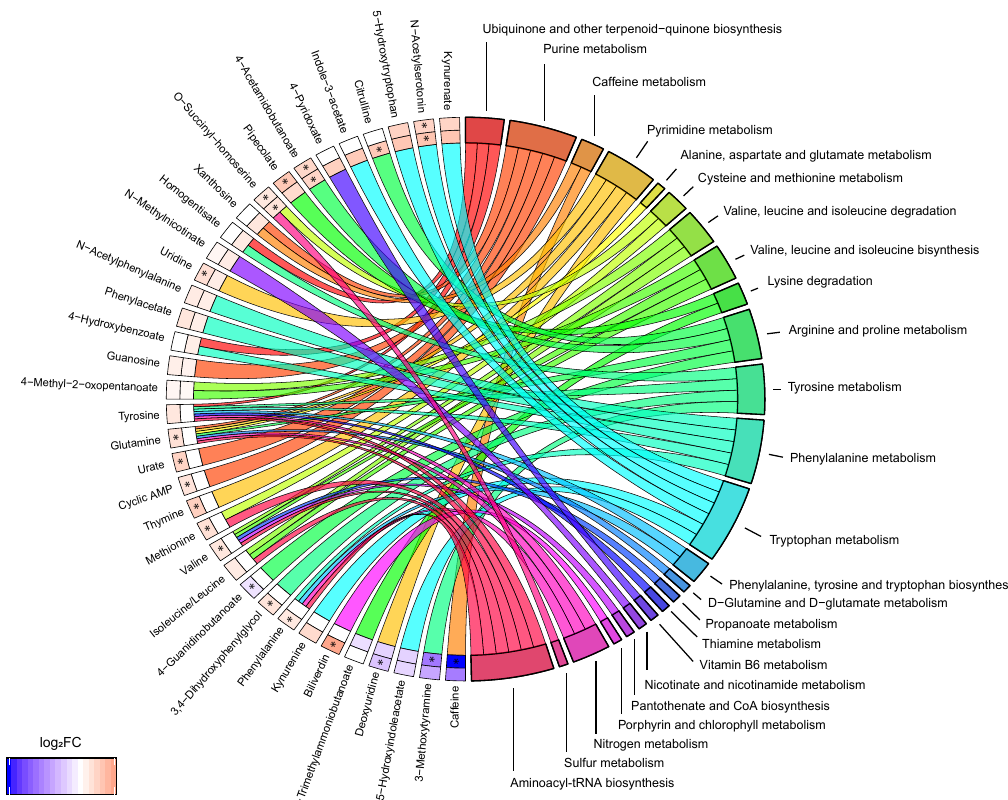
Figure 2. Metabolite to biochemical pathway linkages. The altered metabolites have been linked with pathways as color-coded ribbons. Blue-to-red coding next to the altered metabolites indicates the magnitude and direction of the log 2 fold change (FC), where the inner layer represents FC in comparison with controls (SP-C) and the outer in comparison with RRMS (SP-RR). Significant FC with an FDR < 0.05 have been marked with a ‘*’.